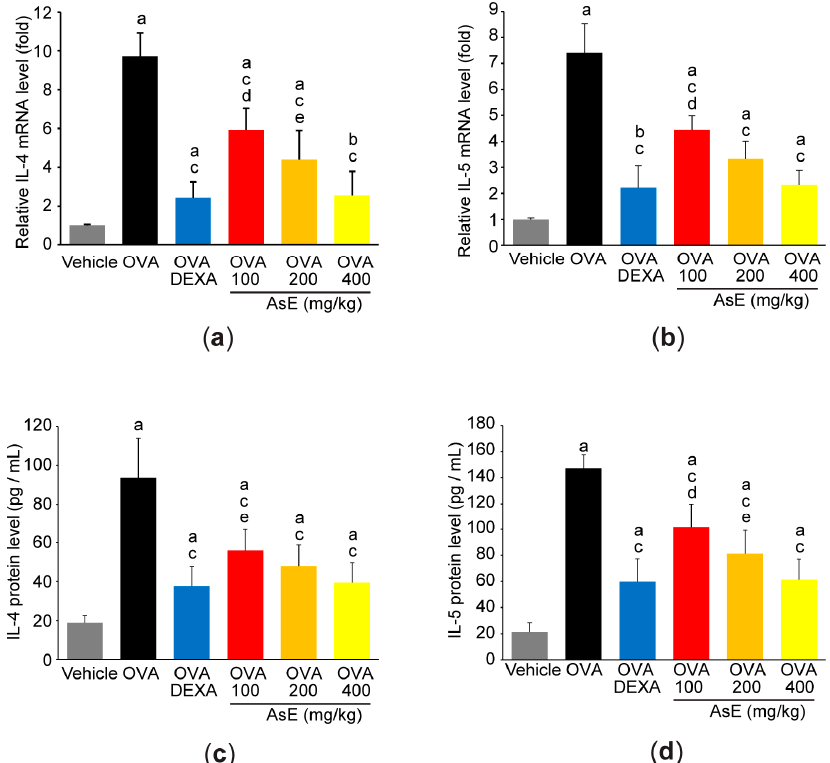
Figure 4. AsE attenuates IL-4 and IL-5 production in OVA-induced allergic asthma. mRNA levels of IL-4 ( a ) and IL-5 ( b ) in the lower right lobe of the lung were quantified by real-time PCR. In addition, IL-4 ( c ) and IL-5 ( d ) proteins in BALF were quantified by ELISA. a p < 0.01, b p < 0.05 versus vehicle group; c p < 0.01 versus OVA group; d p < 0.01, e p < 0.01 versus OVA + DEXA group; BALF, bronchoalveolar lavage fluid; ELISA, enzyme-linked immunosorbent assay; IL, interleukin; PCR, polymerase chain reaction.